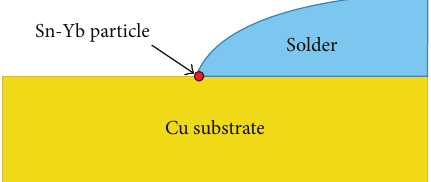
Figure 3: Schematic of Yb effect on wetting angle